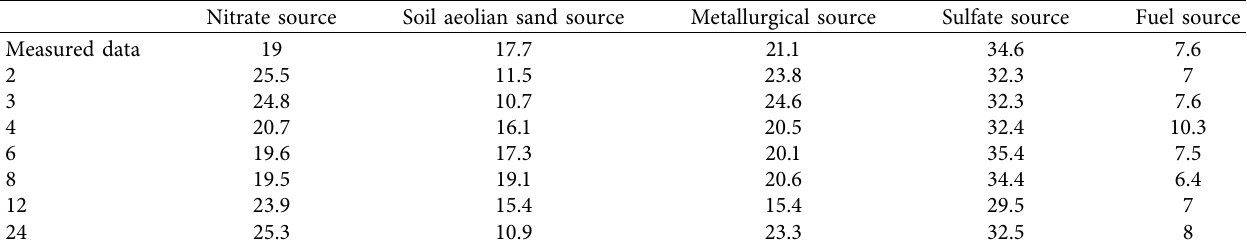
Figure 3: Data processing diagram. Table 1: Comparison of source contribution rates between measured data and normal extended data (unit: %).